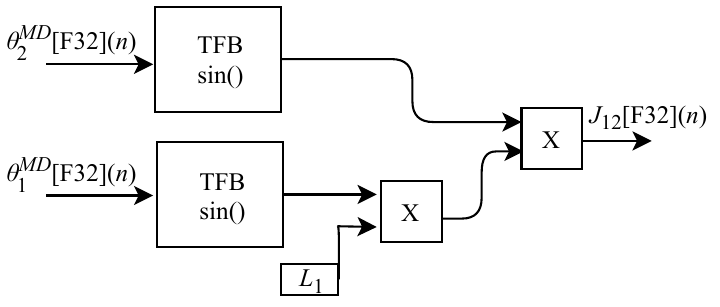
Figure 20. Proposed circuit to calculate the Jacobian matrix J 12 [ F 32 ]( n ) (Equation (32))—JM.